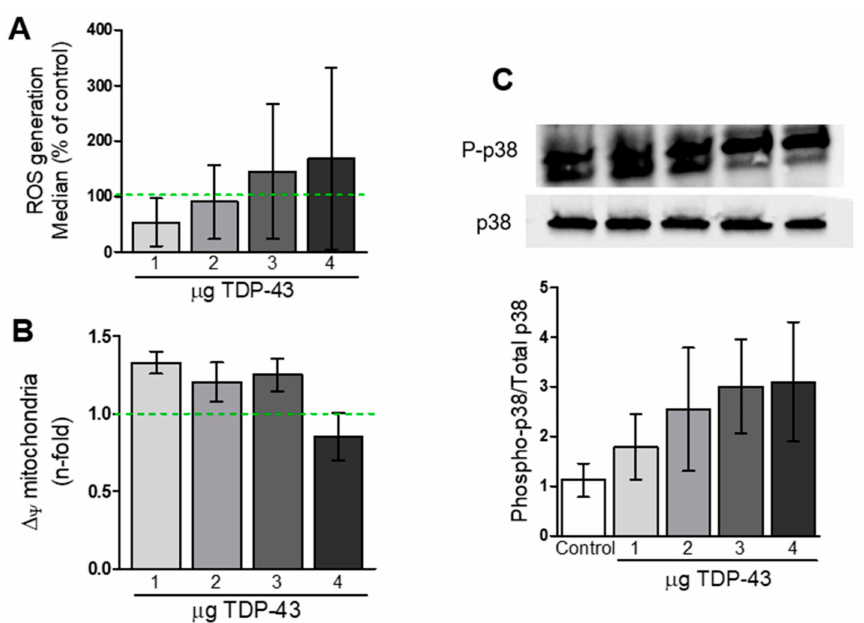
Figure 4. Analysis of TDP-43 overexpression, oxidative stress, and impairment in mitochondrial membrane potential in HEK293T cells. ( A ) Median fluorescence of DCF-DA signal from TDP-43-transfected cells in relation to the control. Statistical analysis revealed no di ff erences between groups. ( B ) Membrane mitochondrial potential analyzed with TMRM probe revealed no alterations induced by TDP-43 overexpression ( n = 3–8). ( C ) Western blot analysis of p38 phosphorylation in